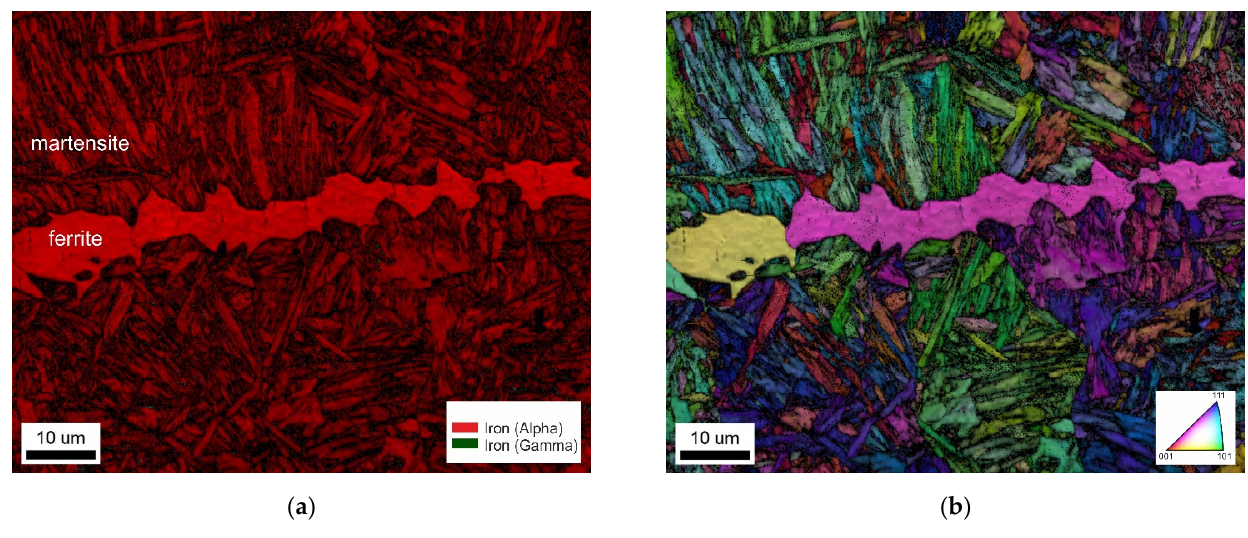
Figure 9. ( a ) Phase map and ( b ) IPF+IQ map of laser weld FZ.